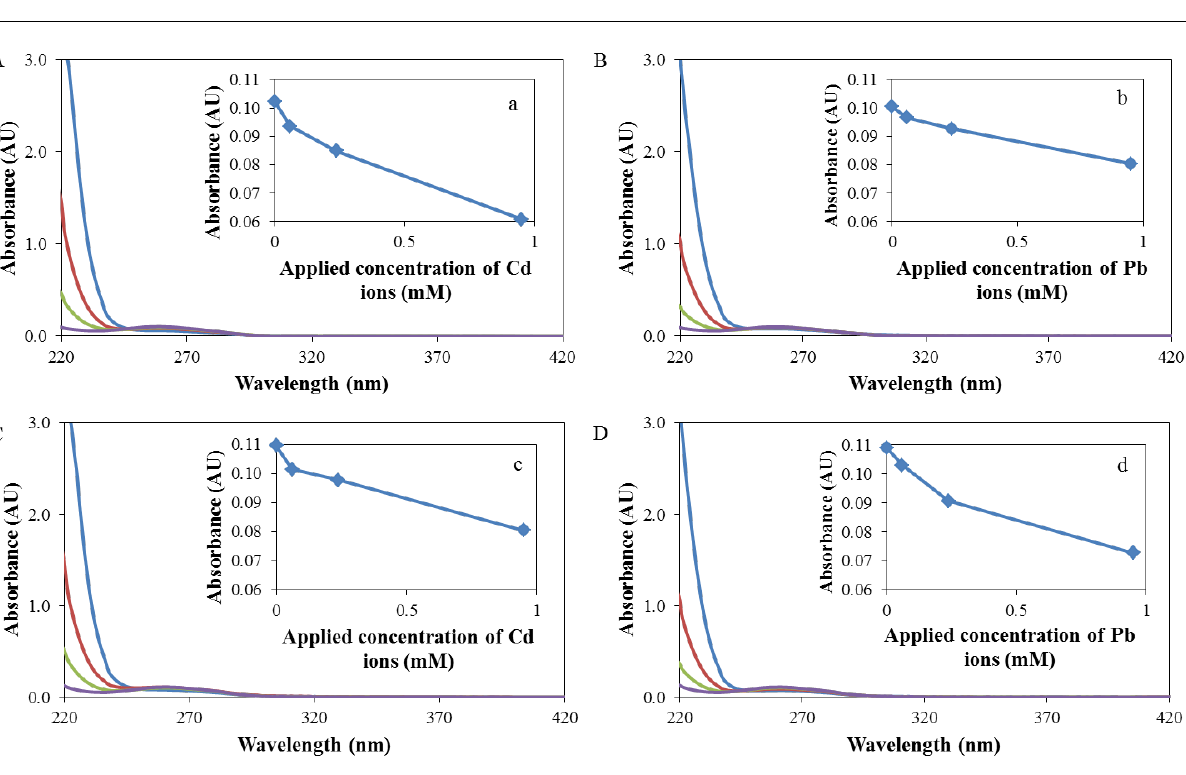
Figure 4. Interaction of bacterial DNA fragment with different concentrations of heavy metal ions (• 0, • 60, • 240 and • 950 μM): ( A ) Interaction of 16S gene with cadmium ions, ( a ) decrease of absorbance of 16S gene with cadmium ions in 260 nm. ( B ) Interaction of 16S gene with lead ions, ( b ) decrease of absorbance of 16S gene with lead ions in 260 nm. ( C ) Interaction of zntR gene with cadmium ions, ( c ) decrease of absorbance of zntR gene with cadmium ions in 260 nm. ( D ) Interaction of zntR gene with lead ions, ( d ) decrease of absorbance of zntR gene with lead ions in 260